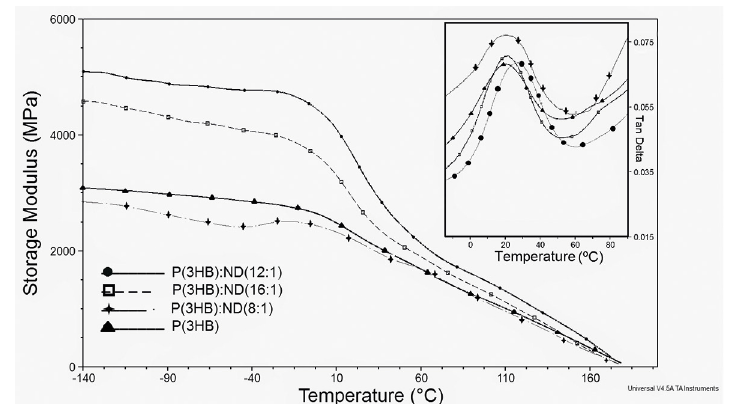
Figure 5: Storage modulus and tan delta per temperature curves for all